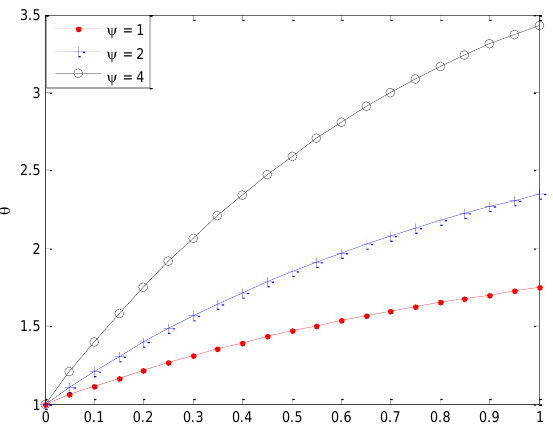
Fig. 5. Effect of heat realized term on the temperature profile